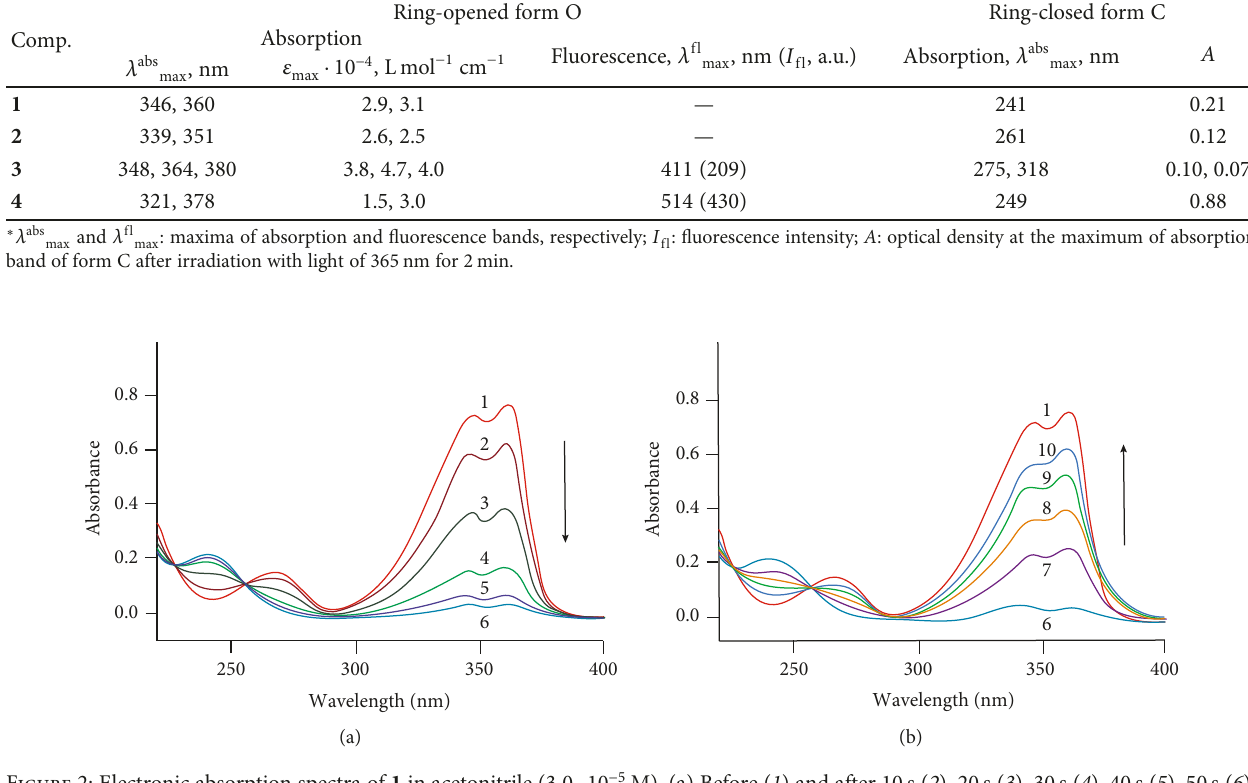
Table 1: Electronic absorption and fl uorescence spectra of isomeric forms of 1 – 4 in acetonitrile ∗ . Comp.